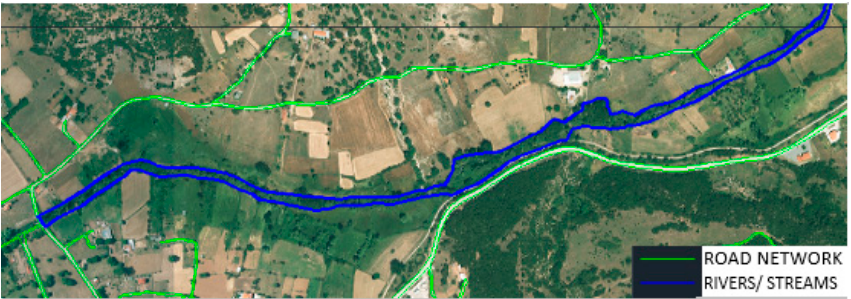
Figure 9. Digitization of the river on the orthophoto using photo-interpretation tools. Source: [35].